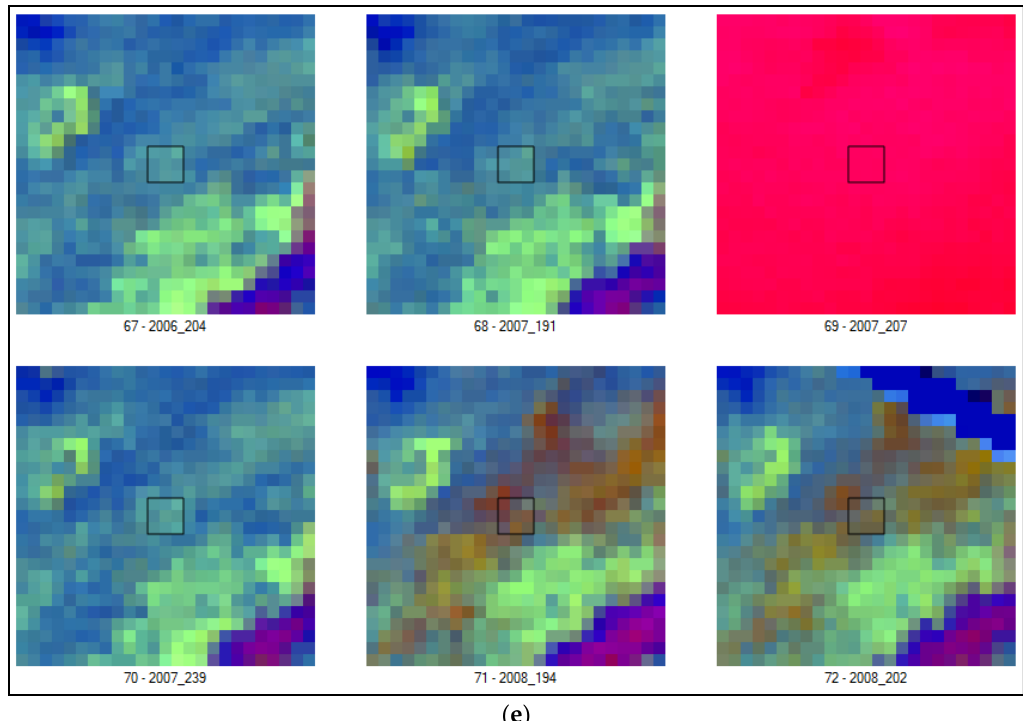
Figure A7. A 2008 Tree Toppling patch generated by LandTrendr at Olympic National Park. ( a ) Photo collected during field validation. Photo credit: NPS (2008). ( b ) Pre-disturbance 2006 aerial photo as viewed in Google Earth™. ( c ) Post-disturbance 2009 aerial photo as viewed in Google Earth™. ( d ) TimeSync spectral trajectory of nine pixels around patch centroid. ( e ) Part of the series of tasseled-cap image chips covering pre- and post-disturbance years as viewed in TimeSync. Dark blue streaks in ( e ) correspond to Landsat 7 missing scan lines and bright red color corresponds to clouds.